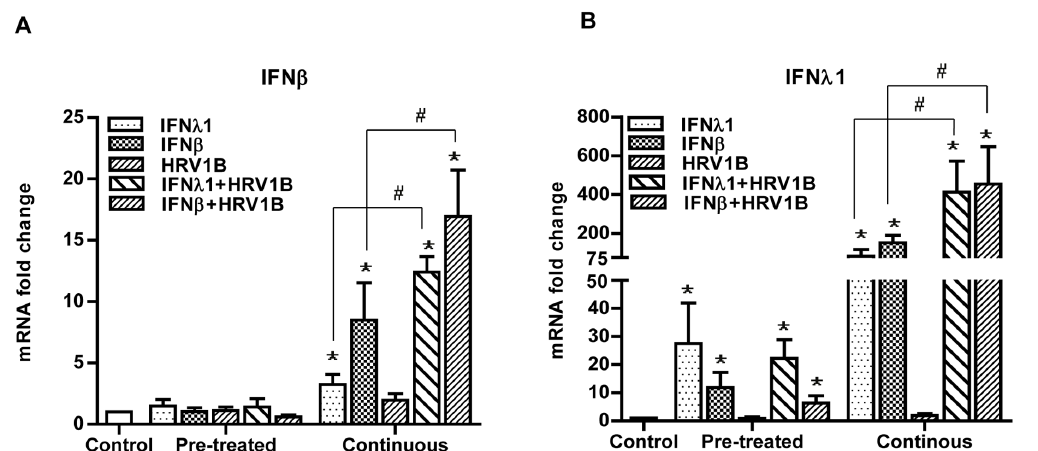
Figure 3. Priming effect of IFNs on HRV1B-induced interferon response. A549 were first treated with IFNs for 18 h. Next, cells were incubated for another 72 h according to the continuous and pre-treatment approaches. After that cells were infected with HRV1B for 4 h in the same medium. After the infection period, either same medium was maintained on the cells (continuous) or replaced by fresh medium (pre-treated). Thereafter, cells were incubated for another 24 h and then collected for further analyses. mRNA levels of IFN- b (A) and IFN- l 1 (B) were determined by qPCR and fold changes were calculated with the 2 2 DD Ct method. HRV1B induced average IFN- b expression was 1.8 (continuous) and 0.99 (pre- treated) folds and average IFN- l 1 expression was 1.92 (continuous) and 0.90 folds (pre-treated). *, p , 0.05 control vs rest of conditions. # , p , 0.05 IFN vs IFN + HRV1B. n=4.